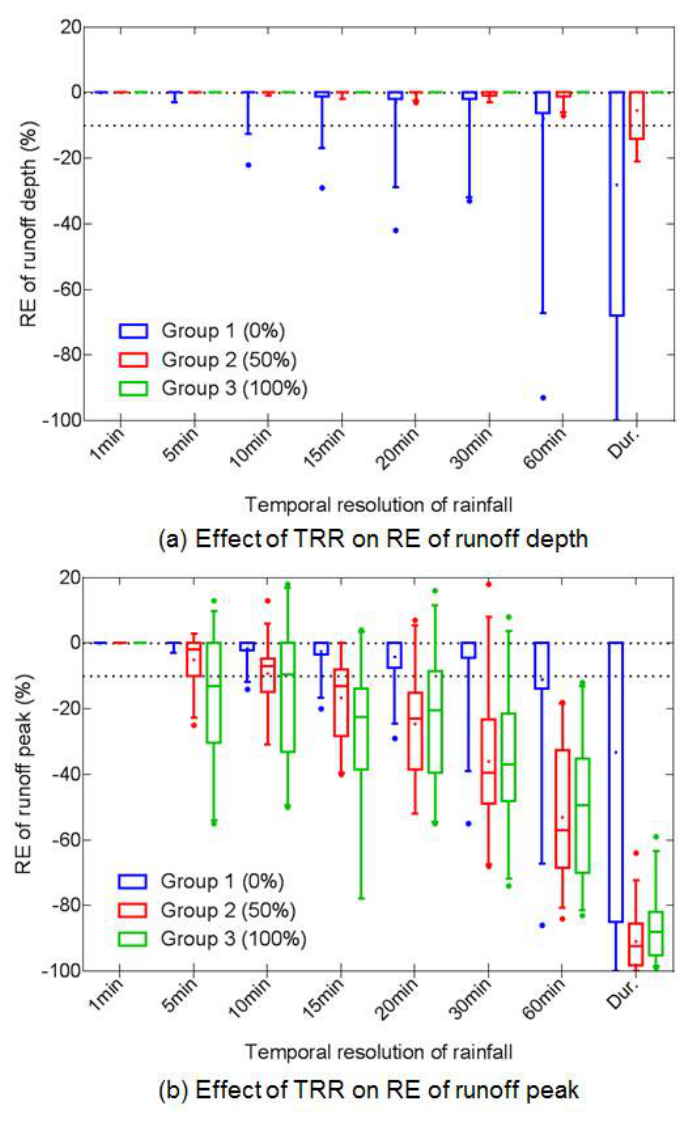
Figure 7. Effect of TRR at grid scale considering the impervious degree. ( a ) shows the effect of runoff depth, and ( b ) shows the effect of runoff peak. Note that the boxplots’ whiskers mean 5–95% of all the 30 events’ results, and points beyond the range are marked as outliers.